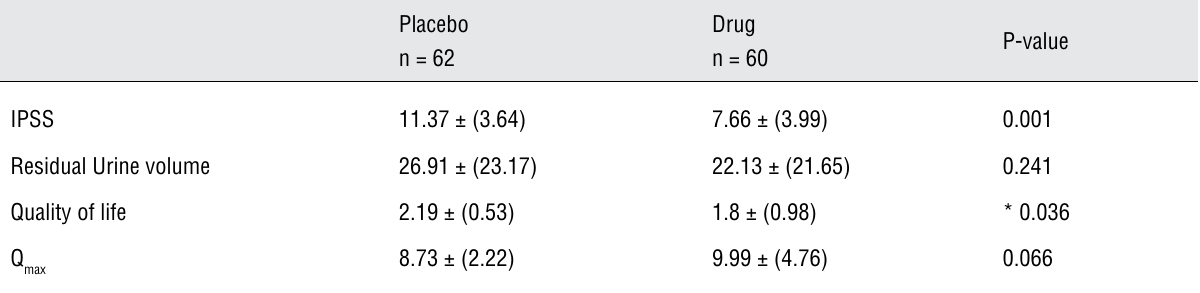
Table 4 - Mean values after treatment of the two